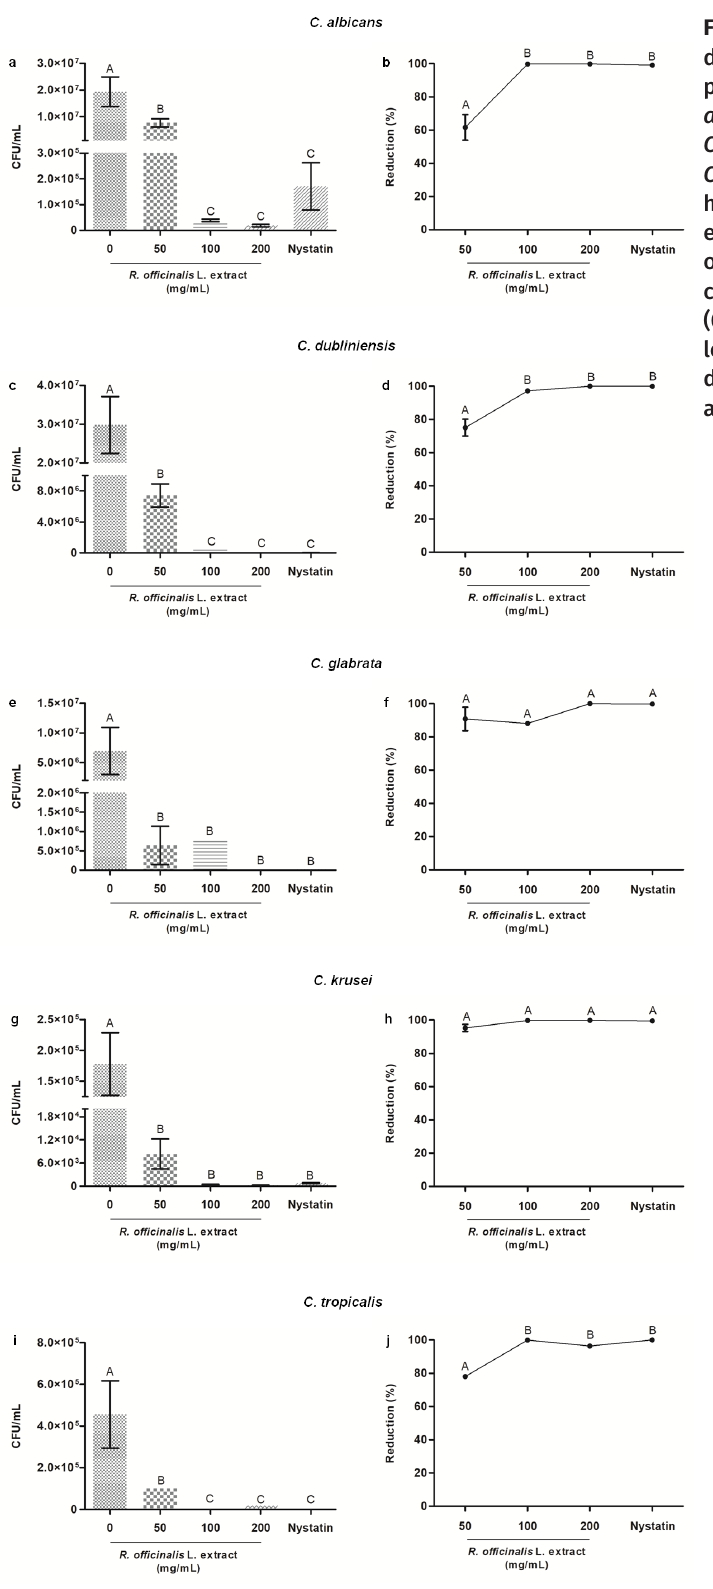
Figure 3. Mean values (± standard deviation) of CFU/mL and reduction percentage (%) of the biofilms of C. albicans (a,b), C. dubliniensis (c,d), C. glabrata (e,f), C. krusei (g,h), and C. tropicalis (i,j) obtained after 24 h exposure to the R. officinalis L. extract (50, 100, and 200 mg/mL) or to the nystatin (100,000 IU/mL), compared to the control group (0 mg/mL – 0.9% NaCl). Different letters indicate significant statistical difference. ( n = 10; One-way ANOVA and Tukey’s test; P ≤